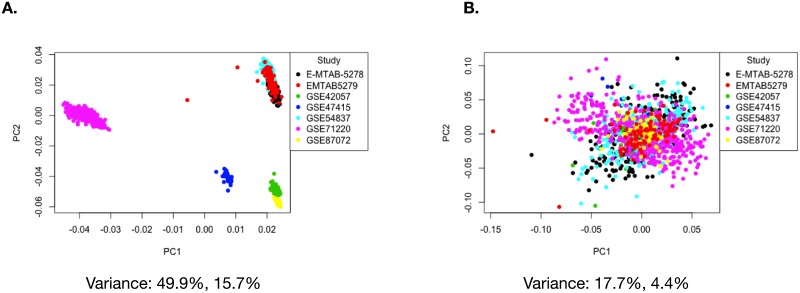
Visualizing batch effects introduced by using multiple studies in our analysis.(A) PCA before and (B) PCA after batch effect correction with ComBat.